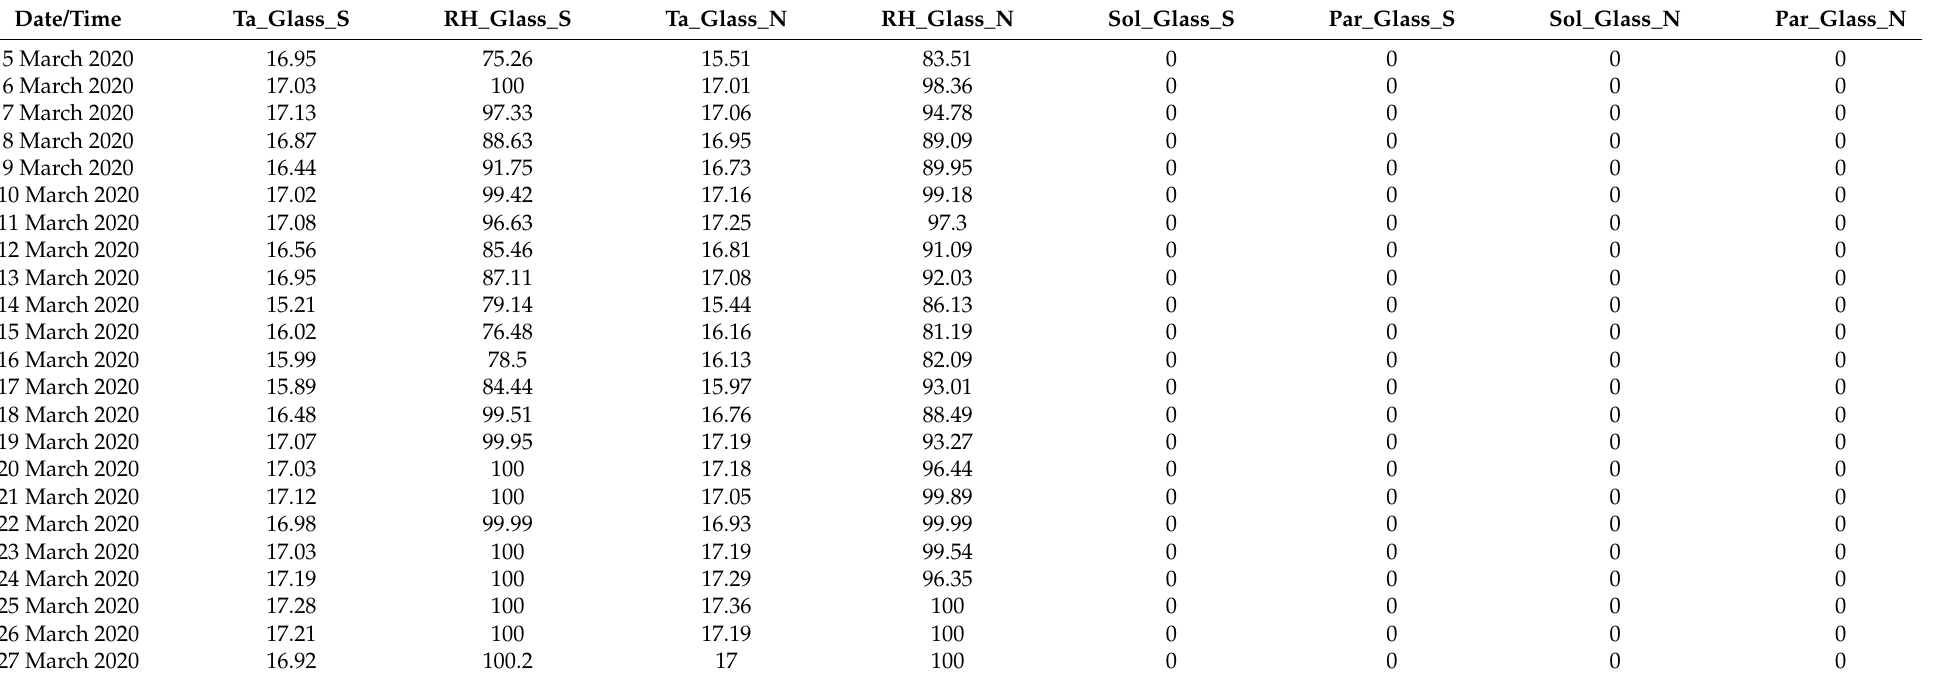
Table 5. Mean night-time variations of climatic parameters over the measurement